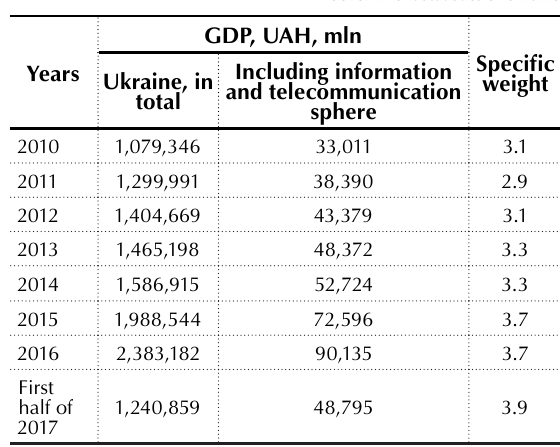
Table 1. GDP of Ukraine for 2010–2017, UAH mln in actual prices (except for temporarily occupied